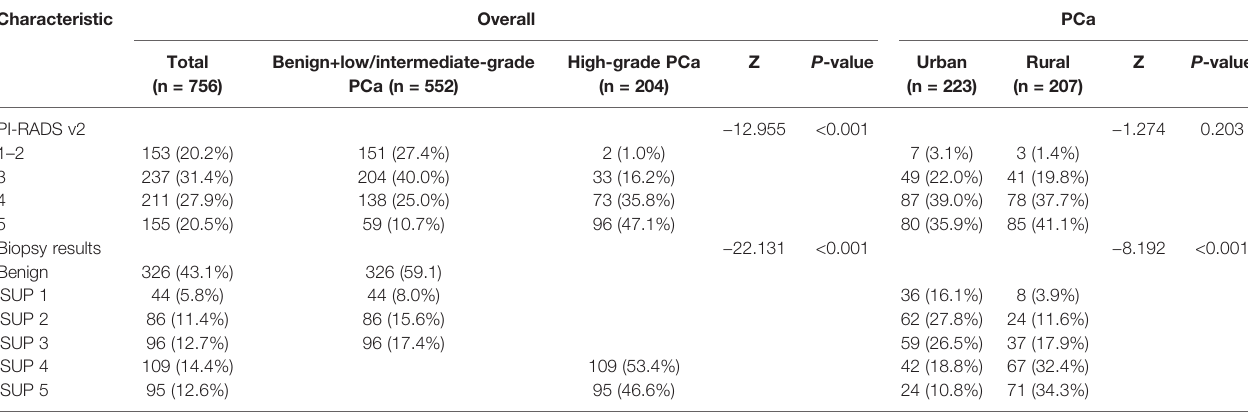
TABLE 2 | PI-RADS v2 and biopsy results of study participants. Characteristic